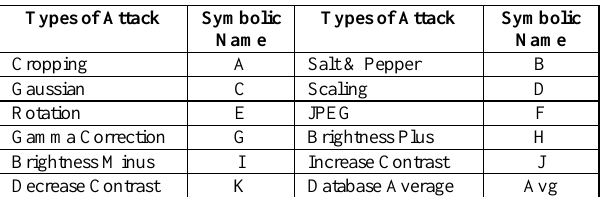
Table 2. Symbolic names for various operations